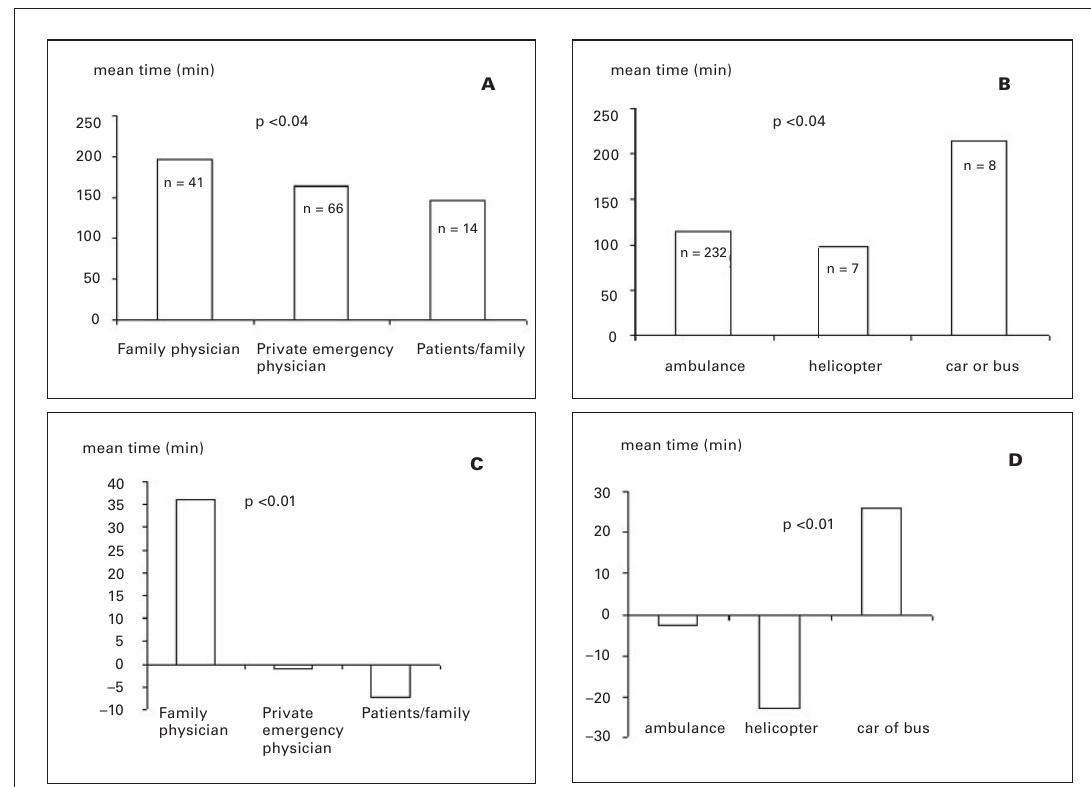
In-hospital delays between arrival at ED and request for CT- scan (A and B) and call to neurologist (C and D) according to referral patterns (A and C) and mode of transport (B and D). Negative values of mean time indicate that the neurologist was contacted from the ambulance before the arrival at admis- sion. P values were calculated as compar- isons among the dif- ferent